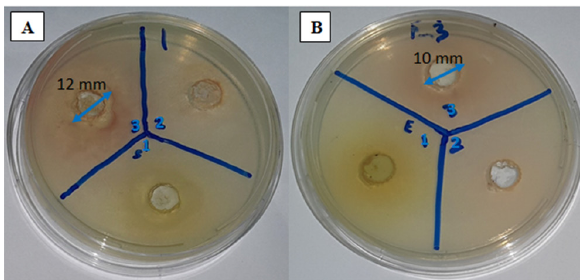
Figure 9: Created zones of inhibition with S. aureus (A) and E. coli (B) incubated at 37°C for 24 h.